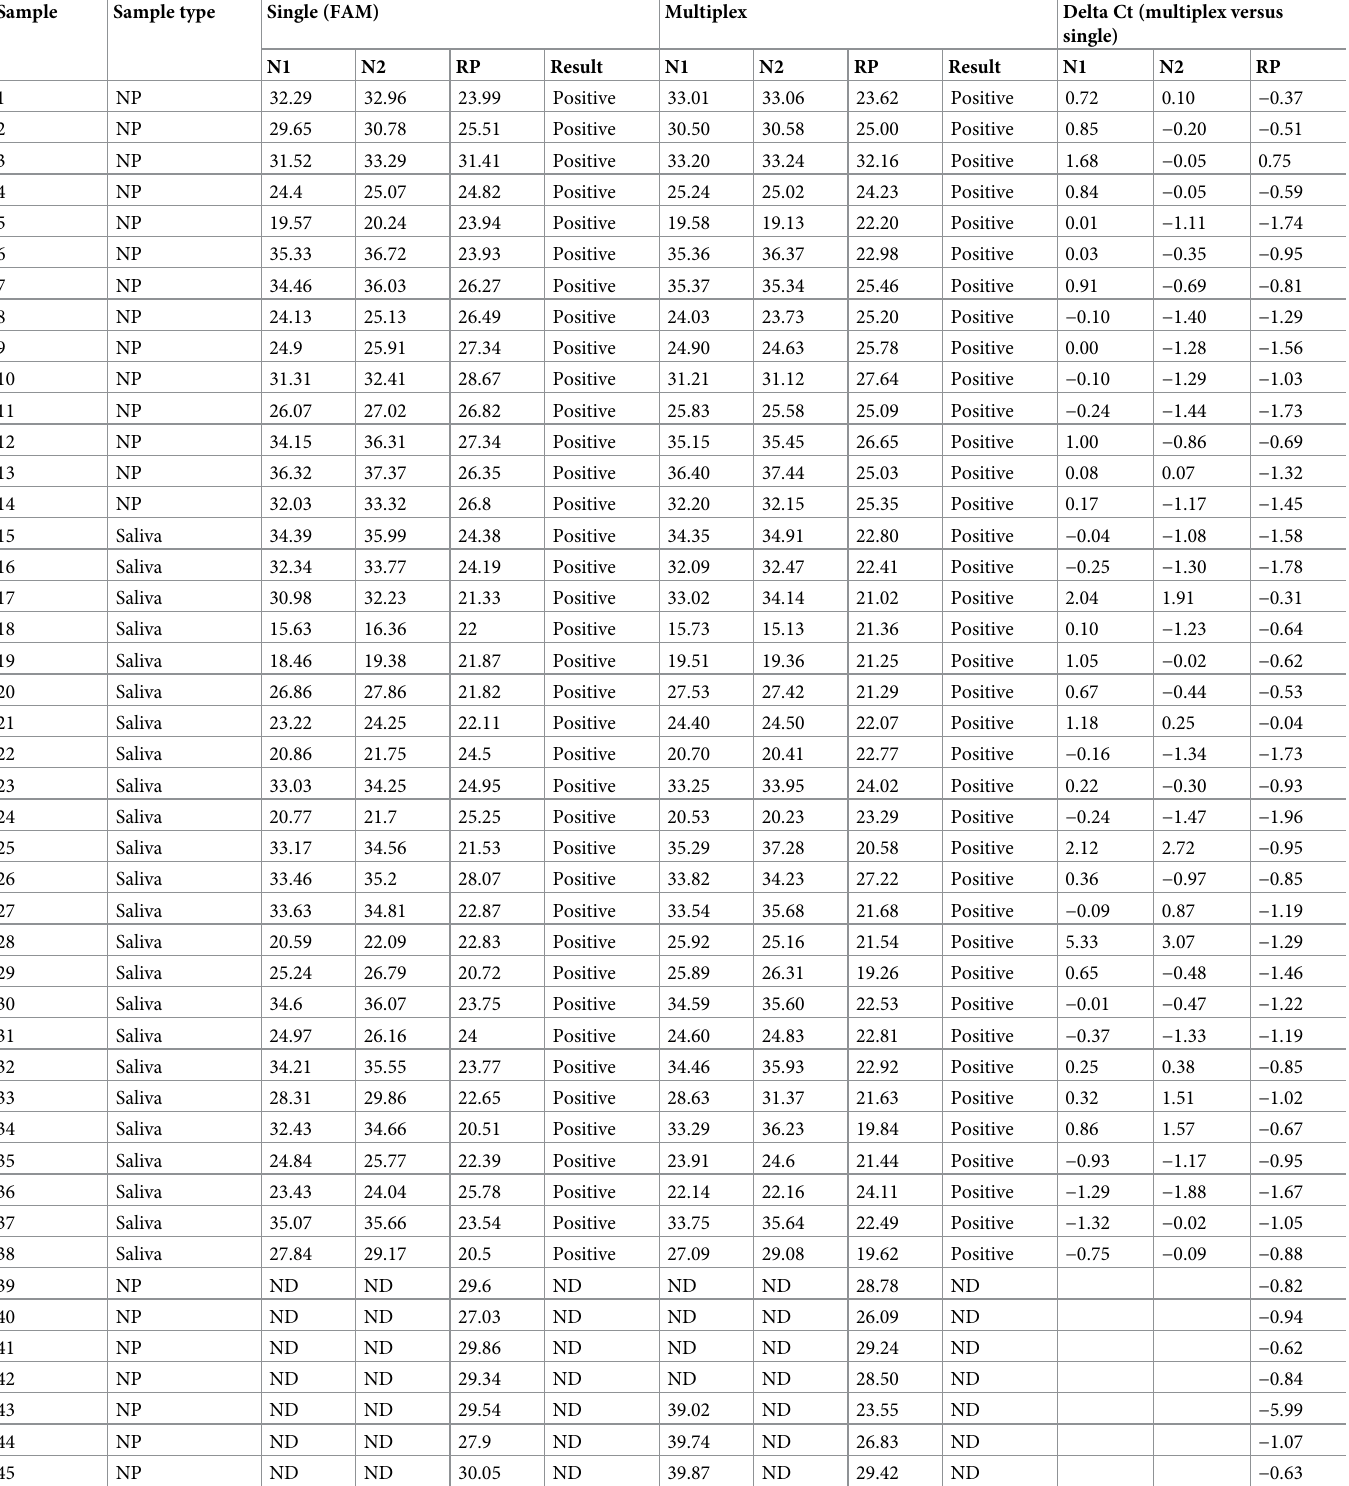
Table 3. The Ct values and results from the multiplex assay in clinical samples.